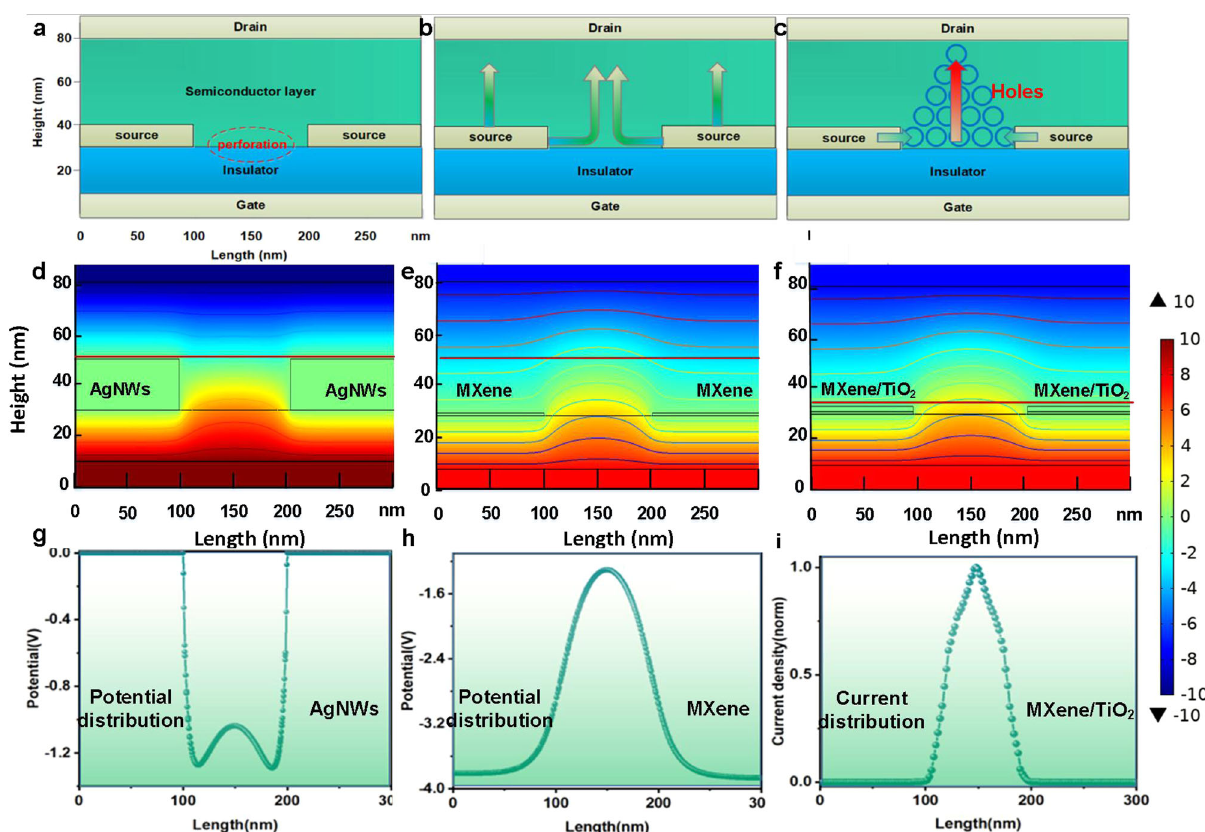
Fig. 4 The potential and current distribution of VOFET as a function of the geometry of source electrode. a The schematic of simulated device structure. b The current distribution of VOFET. c The schematic of the accumulation of holes and the formation of pseudo-conductive channel. d , e The potential distribution of AgNWs and MXene based VOFET under V GS = − 10 V, V DS = − 10 V, respectively. f The potential distribution of MXene based VOFET covered with 2 nm TiO 2 . g , h The 1D potential distribution of the red dashed line in d , e . i The 1D current distribution of MVOFET extracted from the red dash line in f